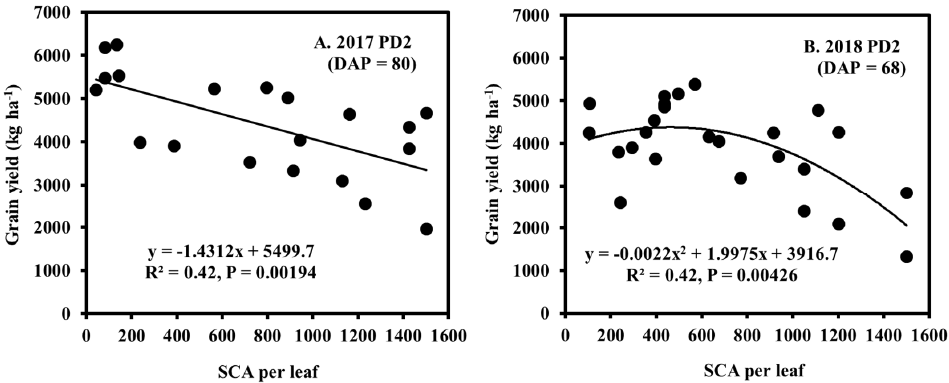
Figure 4. Relationship between SCA and grain yield for PD2 in 2017 ( A ) and 2018 ( B ). Each dot is the data of yield and SCA per leaf in each plot.